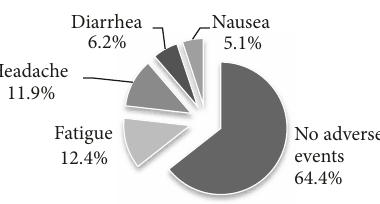
Figure 1: Study design.